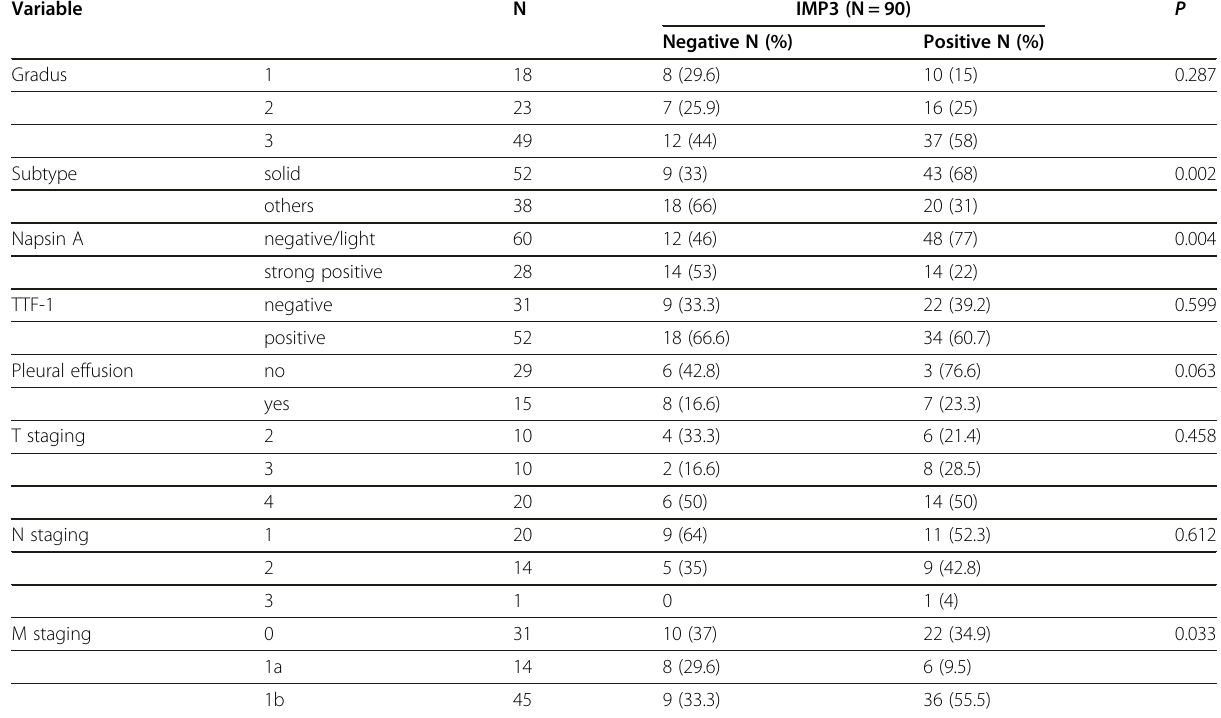
Table 1 Expression of IMP3 in patients with lung